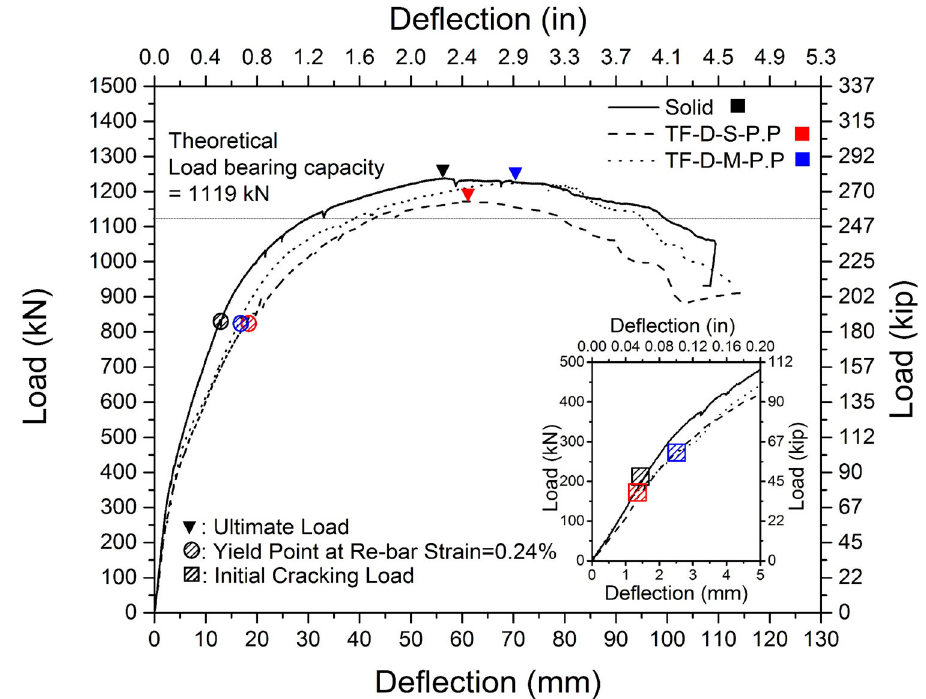
Fig. 8 Load–deflection